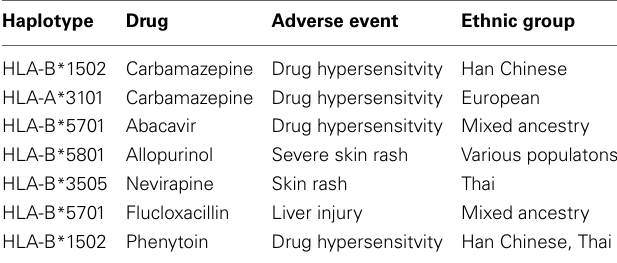
Table 4 | HLA Associations with adverse drug reactions